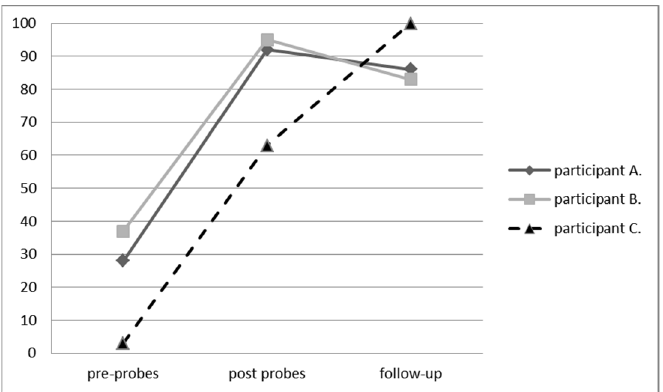
Figure 1. Percentages of positive behavior intervals of the three participants. Probes: 5 min divided in 10 s intervals; follow-up 30 days after training; number of sessions to acquire mastered criterion 48, 22, 9, respectively, for the three participants A, B, and C. The analysis of frequency differences applying a chi-square statistic is 13.372. The p -value is 0.001. The results are significant at p < 0.05. Data analysis was performed using the R package Version 1.15.